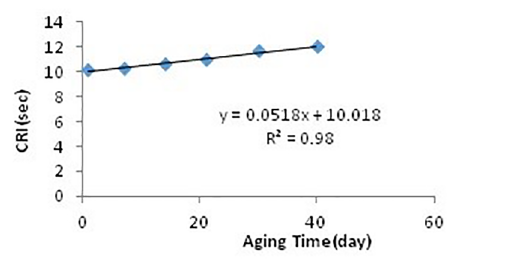
Figure 4. Aging time vs. Normalyze Factor